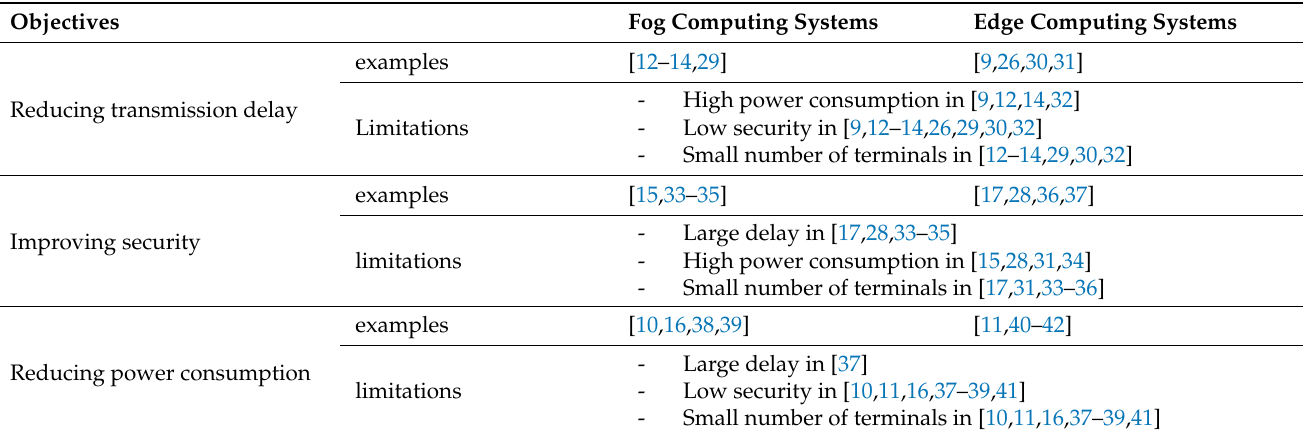
Table 1. Fog and edge computing studies addressing the delay, security, and power consumption issues and the limitations of each